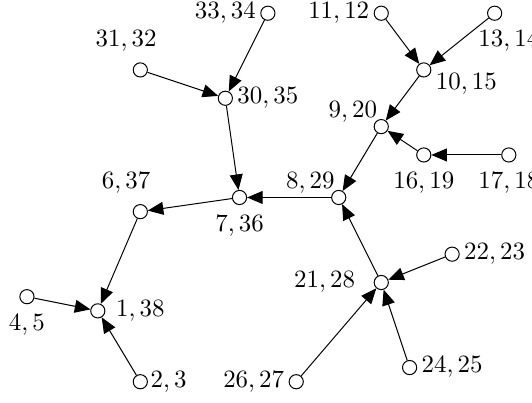
Figure 3 An oriented spanning tree with the values ( Dn , Up ) for each